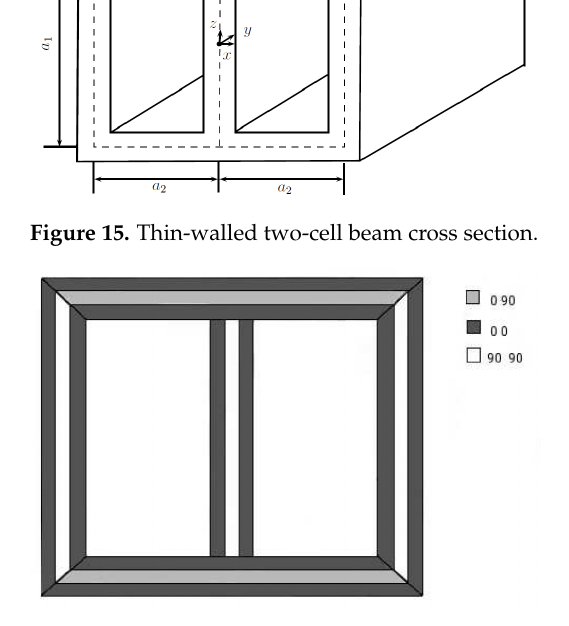
Figure 16. Thin-walled two-cell composite beam cross